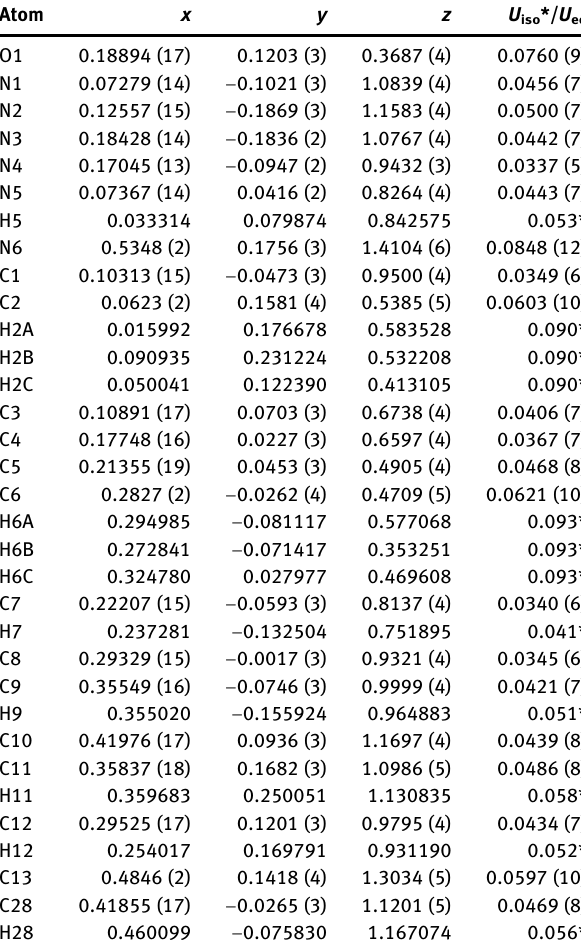
Table  : Fractional atomic coordinates and isotropic or equivalent isotropic displacement parameters (Å 